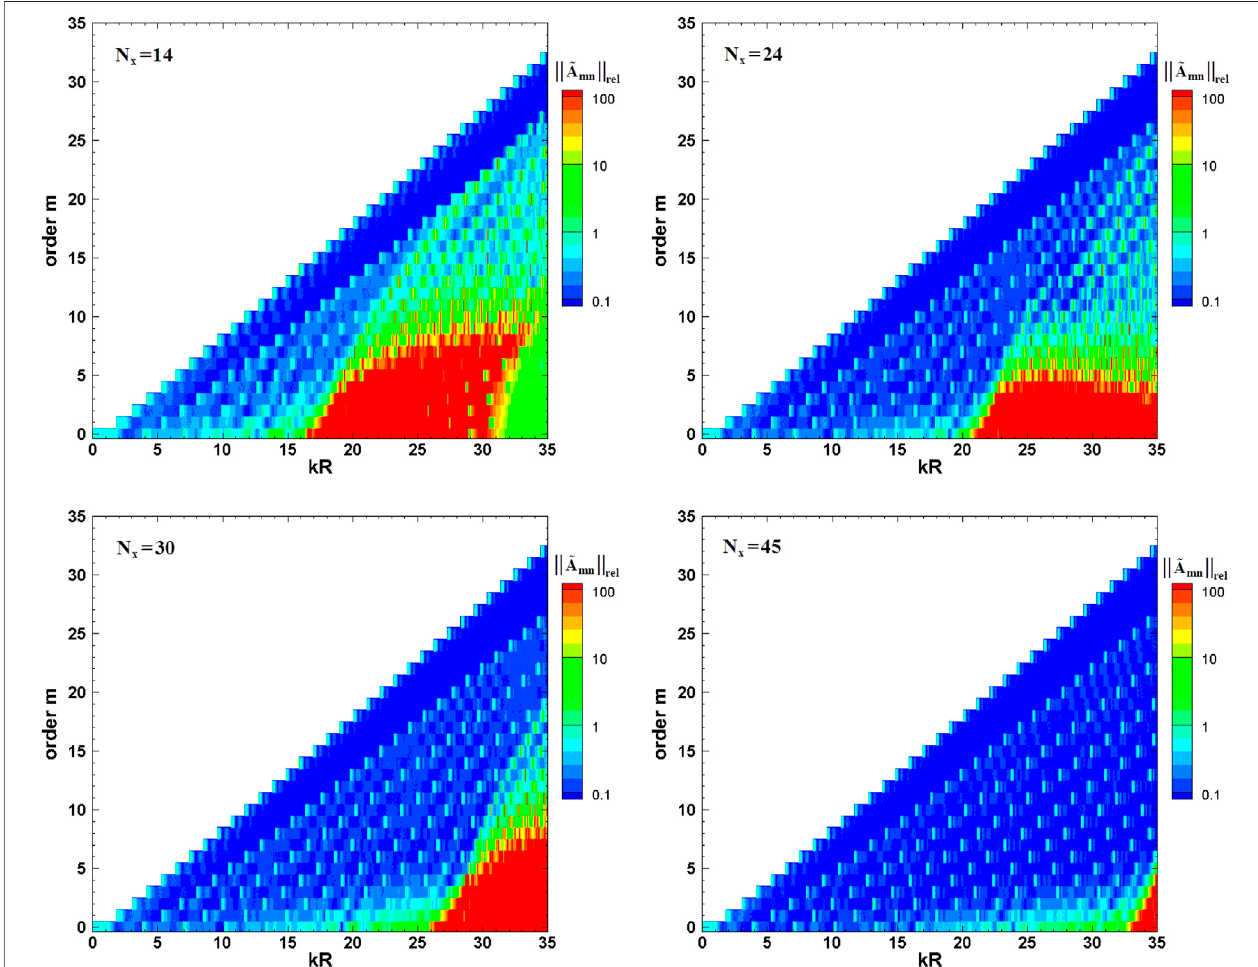
FIGURE 6 | Relative accuracy of the four axial arrays under optimum spacing in different circumferential mode decompositions.